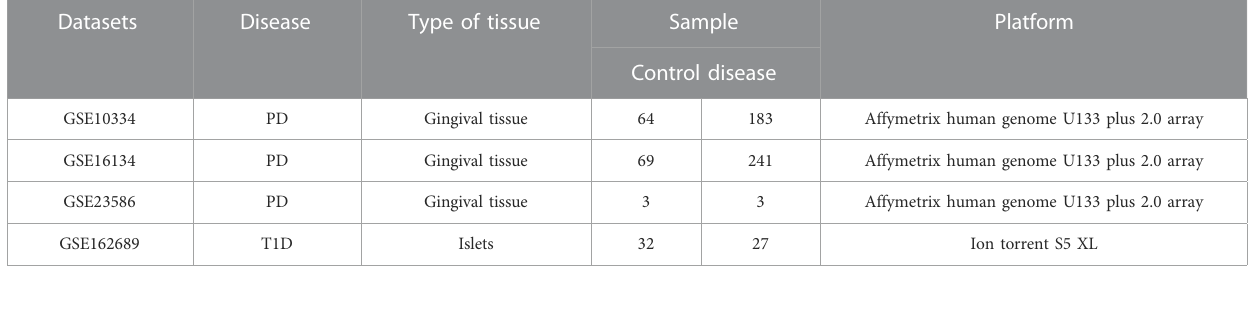
TABLE 1 Description of included datasets.